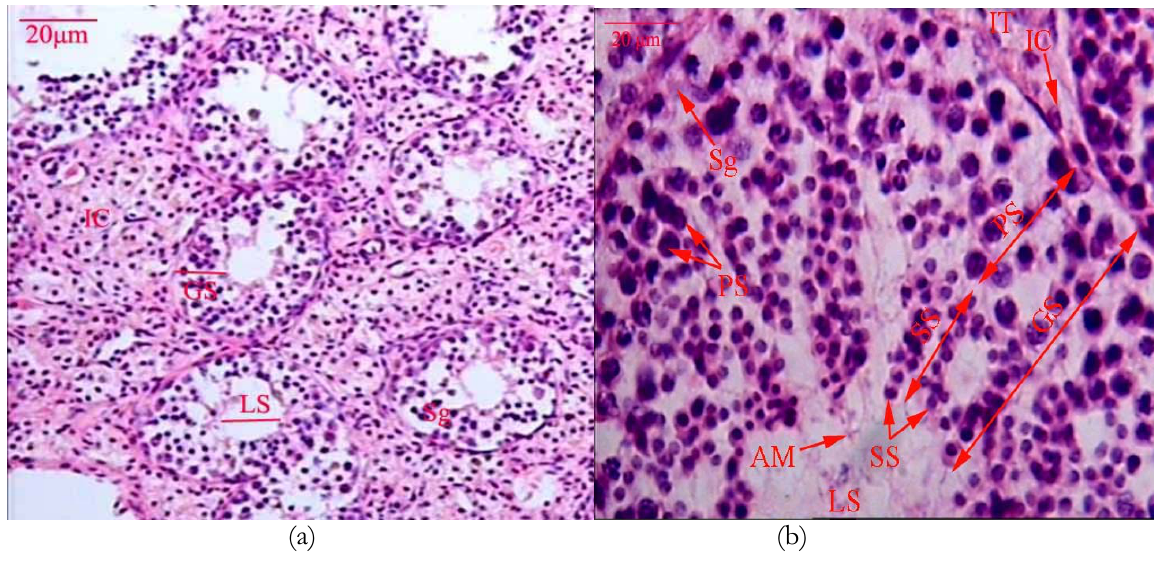
F IG .3. -Histological structure of seminiferous tubules during a: phase (a) and b: phase (b). Abbreviations: GS: Germinative layer of seminiferous; LS: Lumen of seminiferous; Sg: Spermatogonia; SP: Spermatocyte; PS: Primary spermatocyte; SS: Secondary spermatocyte; St: Spermatids; Sz: Spermatozoa; IC: Interstitial cells; IT: Interstitial tissue; AM: Amorphous